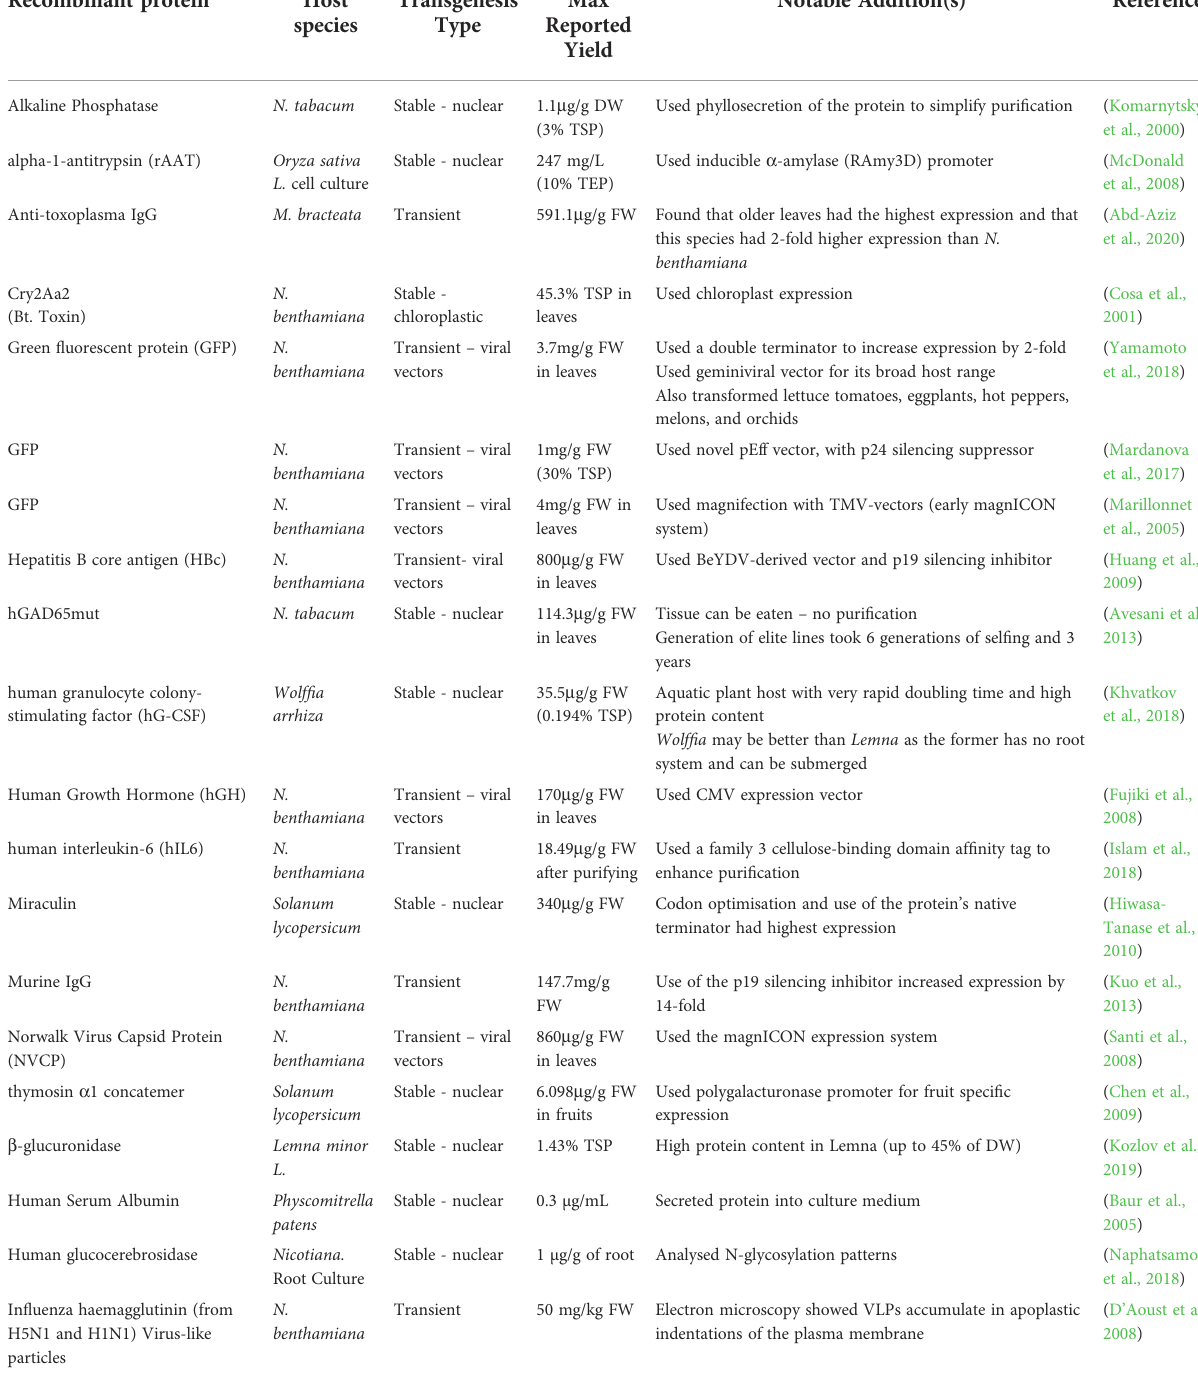
TABLE 2 Selected examples of recombinant protein production in